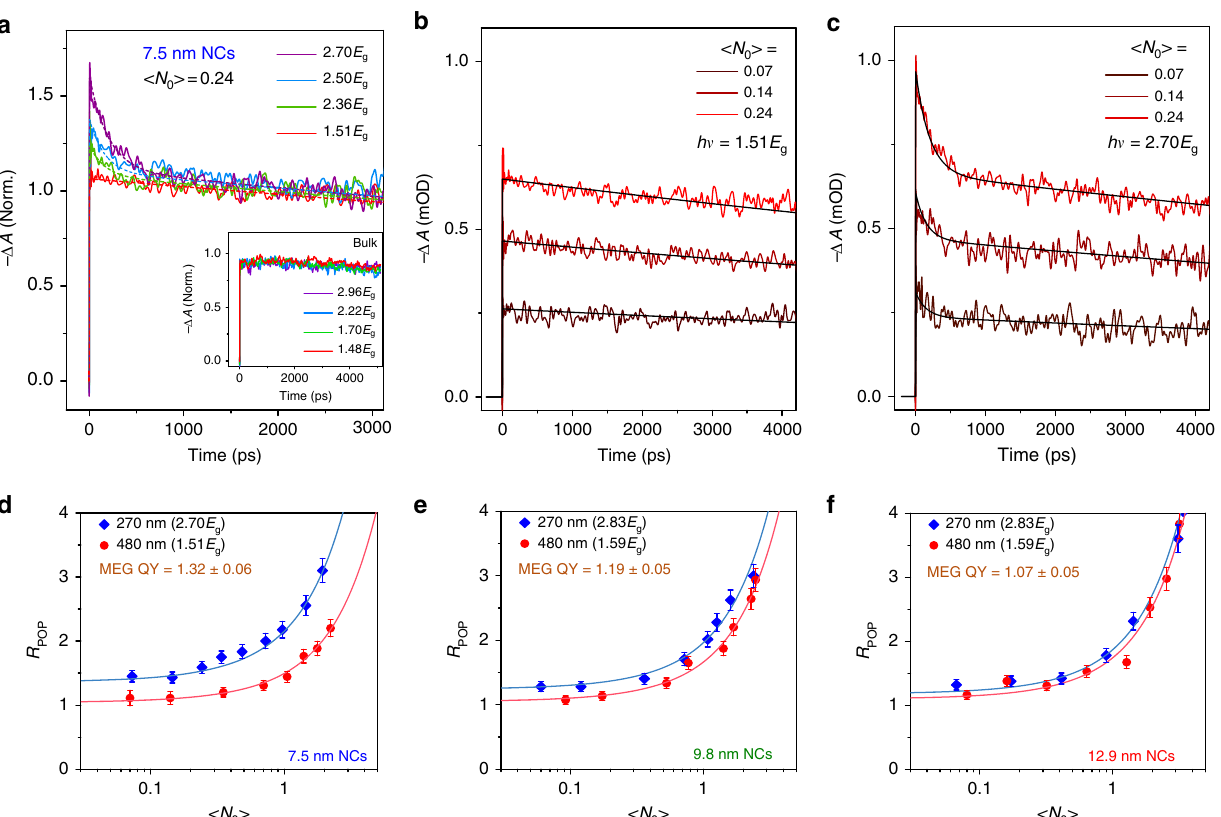
Fig. 2 MEG QY determination from TA dynamics. a Normalized (norm.) band-edge PB dynamics under different pump photon energies with < N 0 > = 0.24 in 7.5 nm-sized FAPbI 3 NCs. Inset shows the similar measurements for the bulk-counterpart with pump fl uence of 2 × 10 17 cm − 3 . TA dynamics generated by photon energy of ( b ) 1.51 E g and ( c ) 2.70 E g for 7.5-nm sized NCs with different average number of absorbed photons per NC < N 0 >. Solid black lines are single exponential in ( b ) and biexponential fi ttings in ( c ), respectively. d – f R POP as a function of < N 0 > under photon energies below and above MEG threshold for three different sized FAPbI 3 NCs. R POP is determined by the PB intensity ratio at the beginning of pump excitation at a delay time of 2 ps to that at a delay time of 4 ns and fi tted with Eq. (1) (solid lines). The error bars in d – f represent the uncertainties in the determination of TA amplitudes in the fi tting procedure of TA dynamics